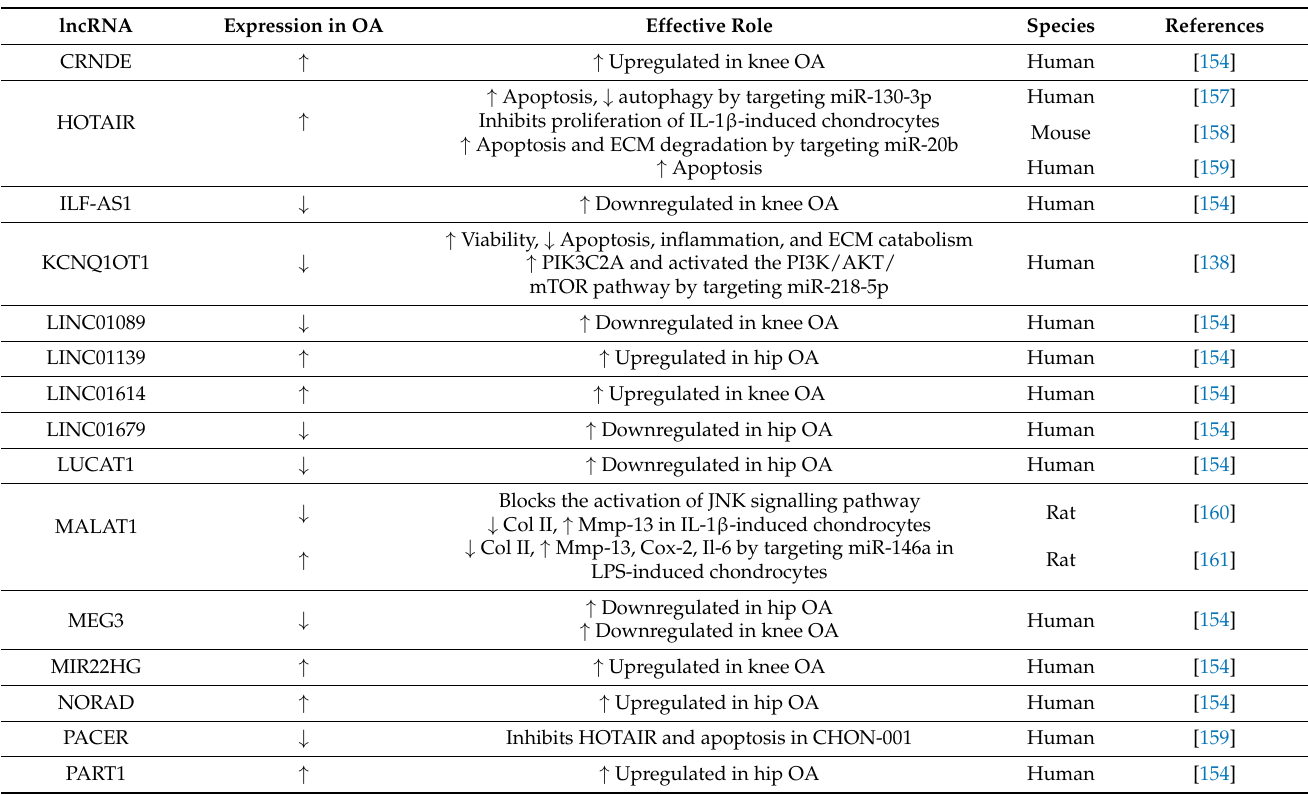
Table 3. Overview of the most relevant lncRNAs in